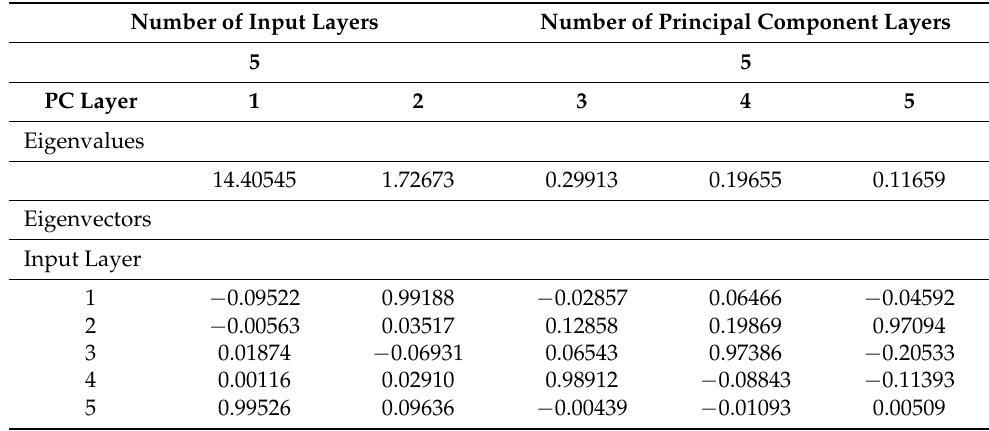
Table 2. Eigenvalues and eigenvectors.